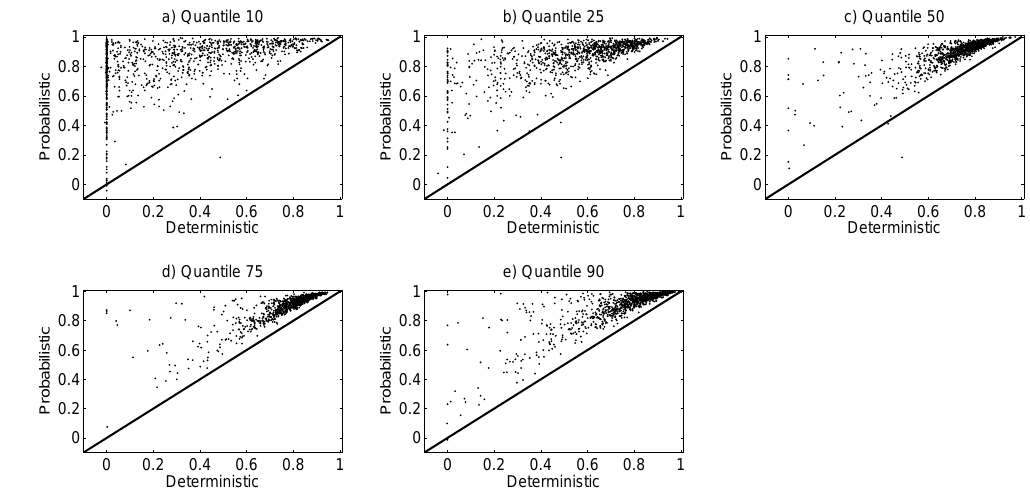
Fig. 10. Probabilistic and deterministic ROC scores for quantiles 10, 25, 50, 75 and 90.